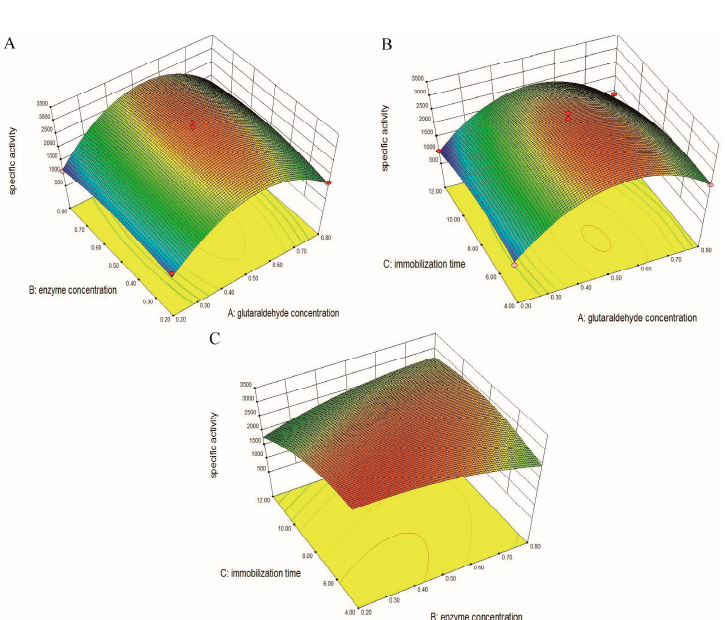
Figure 3. Three-dimensional plots for the interaction effects of A and B ( A ); A and C ( B ); and B and C ( C ) on specific activity.